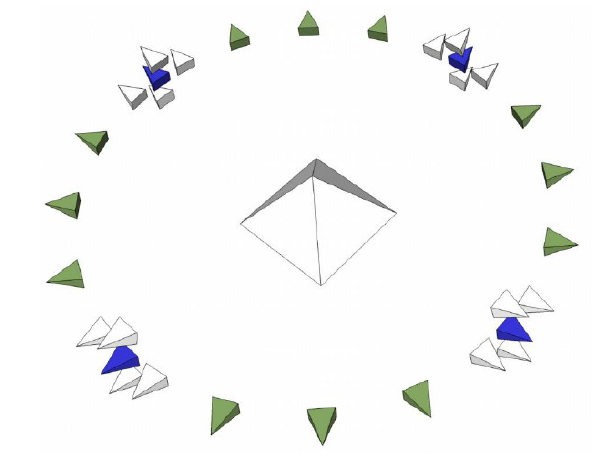
Figure 2: Spatial configuration of the acquisition of an artifact (Nicolas Martin-Beaumont,